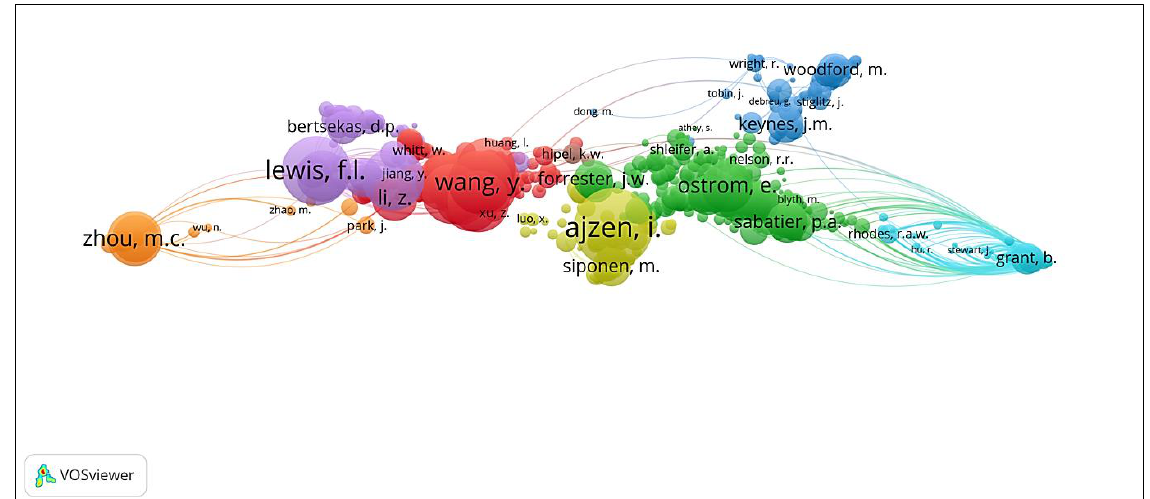
Figure 6. Co-citation network of scholars with theory related policy publications. Note: The figure shows how commonly scholars (with at least ADD citations) are cited together in publications. Nodes denote authors, and their linkages convey co-citation relationships. Larger nodes present authors with more citations. Link strengths indicate the frequency with which they are co-cited. Scholars that are co-cited often are clustered together in nodes of the same